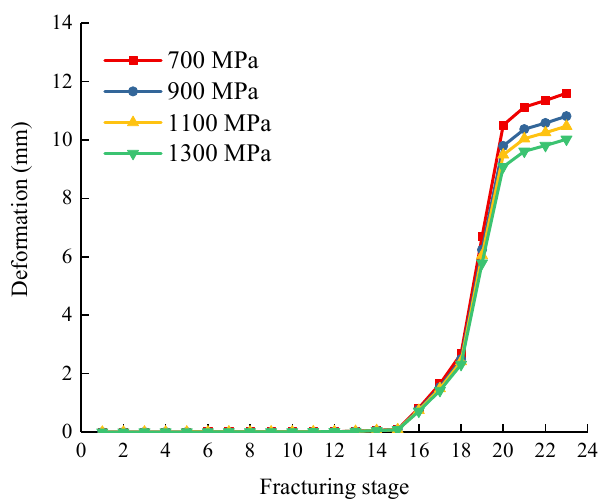
Figure 14. Effect of casing steel grade on casing deformation.